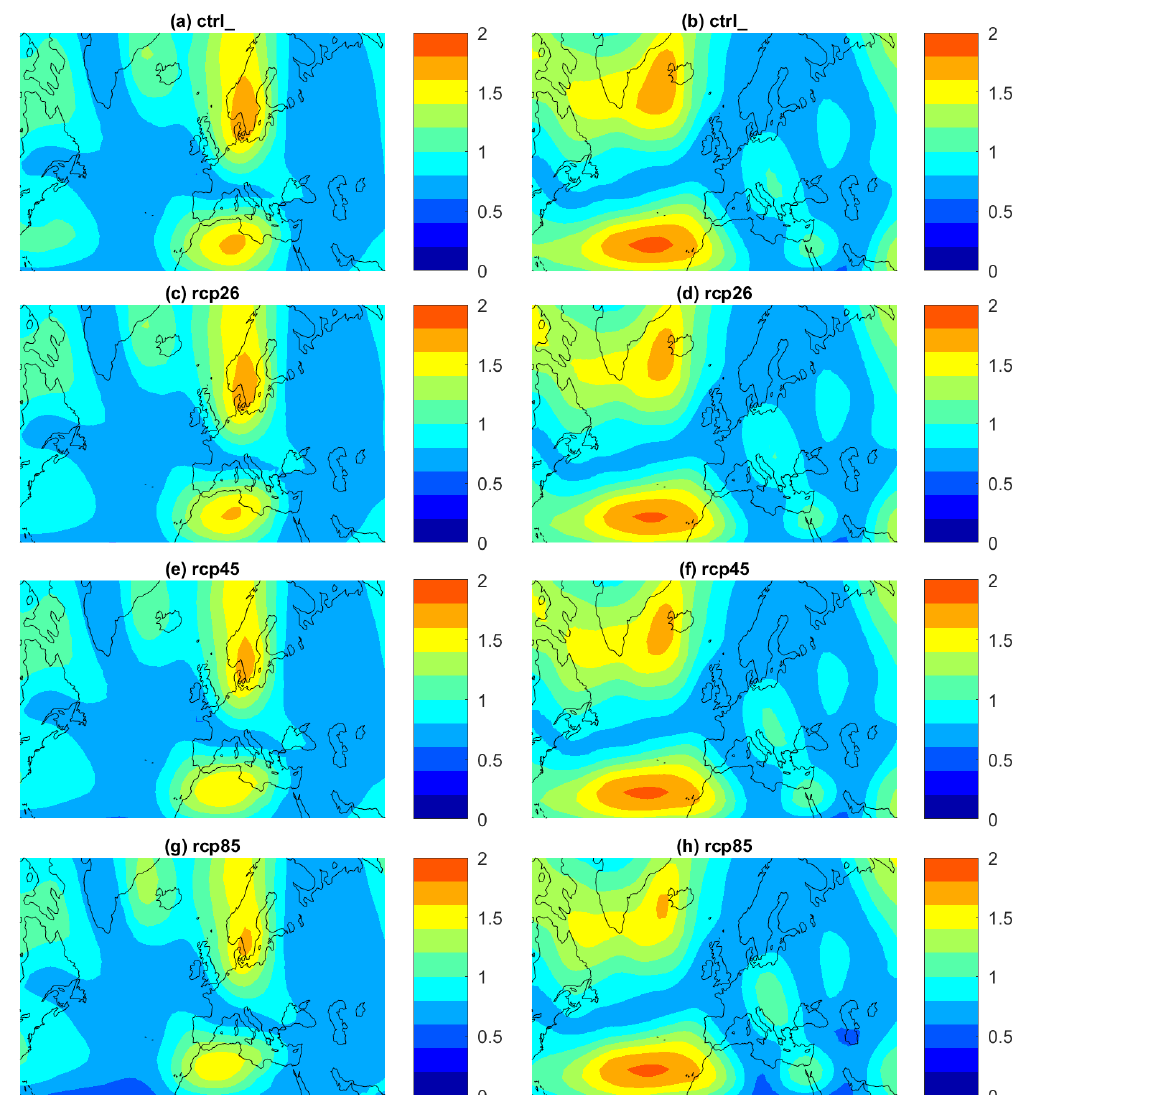
Figure B1. The figure shows 500hPa geopotential height uncertainty in PlaSim analogues: root mean squared difference in standardized 500hPa geopotential height (standard deviations) between analogues and cluster centroids for cluster 1 (a, c, e, g) and cluster 2 (b, d, f, h) . (a, b) Control run. (c, d) RCP2.6 run. (e, f) RCP4.5 run. (g, h) RCP8.5